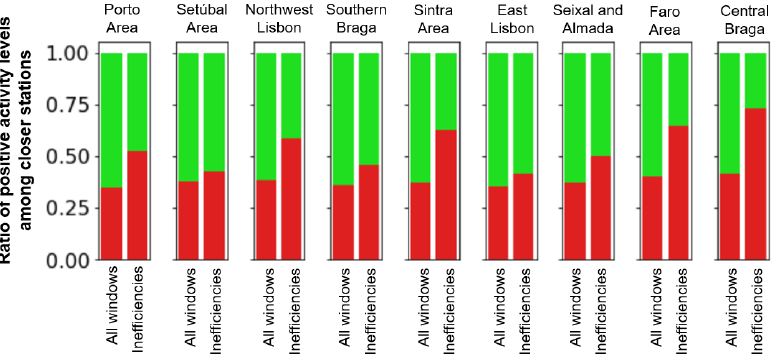
Figure 11. Ratio of positive activity levels among closer stations within the time windows of potential efficiencies versus all time windows.